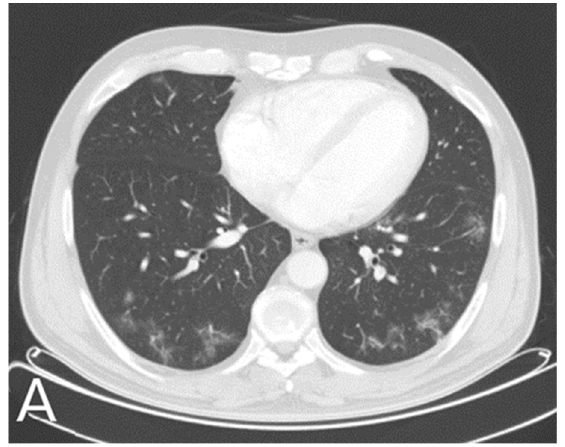
Figure 1. In January 2021.year, 24-year-old male patient with history of Kleine-Levin disease was admitted to the emergency department as a SARS-Cov-2 positive with high fever, cough, dyspnea, anosmia, dysgeusia and fatigue. Symptoms worsened 6 days after the onset of infection, and lung MSCT showed areas of enhanced attenuation by the type of ground glass and patchy consolidations are seen on both sides-bilateral pneumonia ( A ). One month after the onset of the infection, sleep and overeating occurred as it was in 2017. He slept again for more than 18 hours per day, in a wake state he felt constant fatigue and lethargy, he had increased appetite and overeating resulted in a significant increase in body weight. In addition, he lost interest in work and family, completely withdrawing into himself without interest in the environment with occasional outbursts of uncontrolled anger. His father and wife brought him in again for an examination. Apart from somno- lence and disinterest, neurological status was normal, and brain MRI showed numerous changes in white matter (Figure 2B,E). EEG was completely normal.